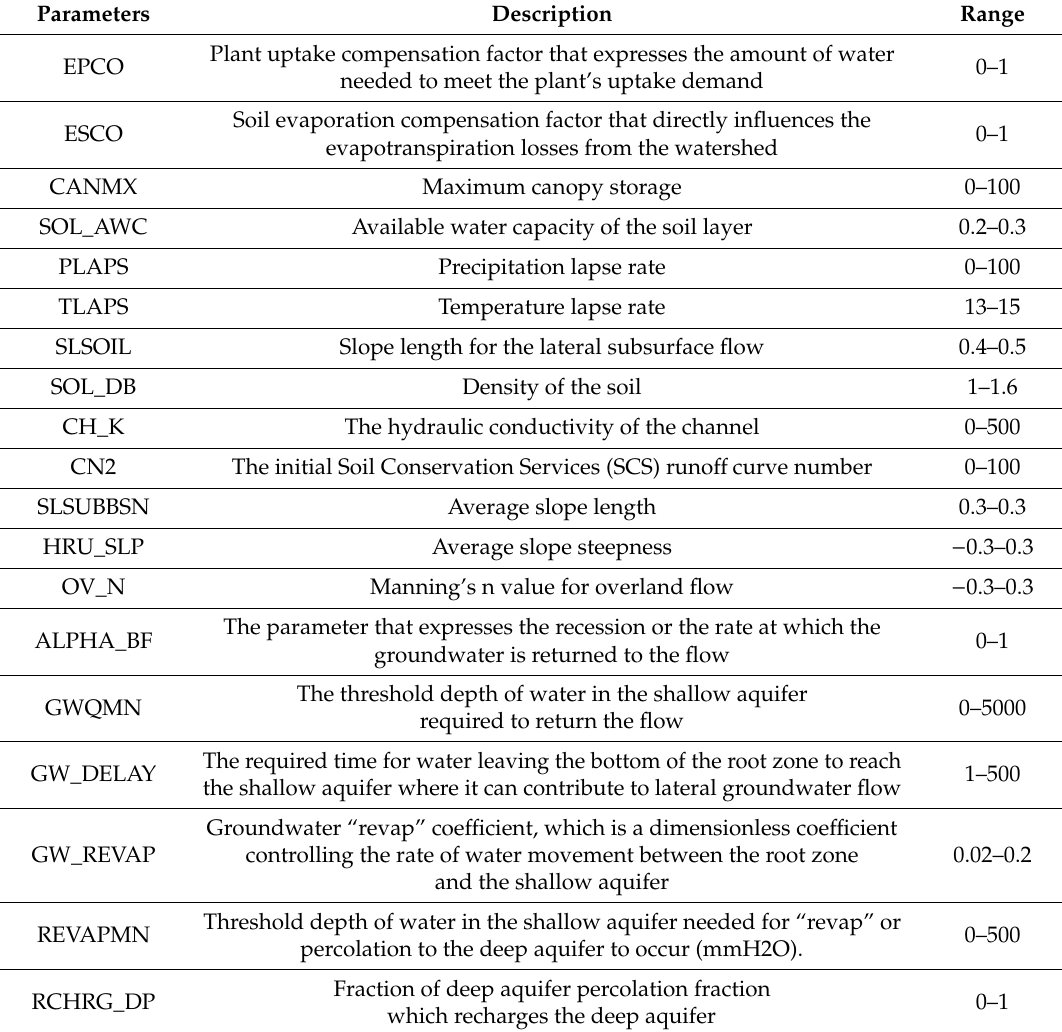
Table 2. List of parameters used for calibration and